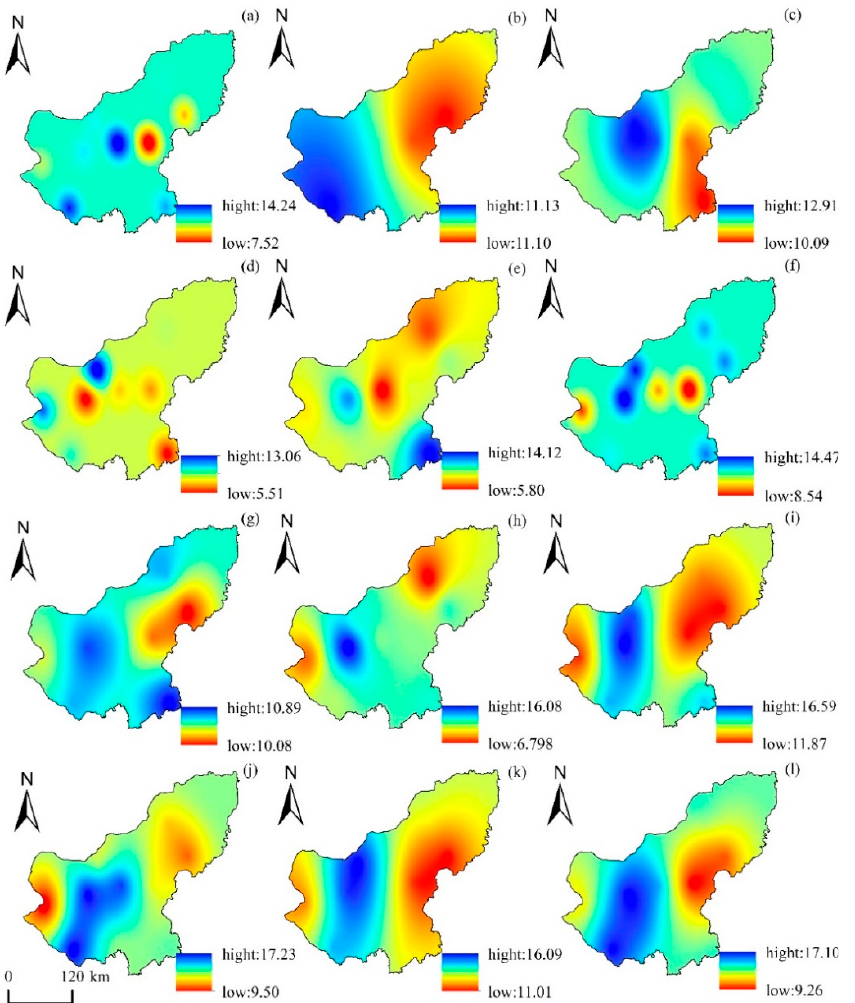
Figure 4. Spatial distribution of scale drought intensity from 1969 to 2018. ( a ) January, ( b ) February, ( c ) March, ( d ) April, ( e ) May, ( f ) June, ( g ) July, ( h ) August, ( i ) September, ( j ) October, ( k ) November, and ( l ) December.